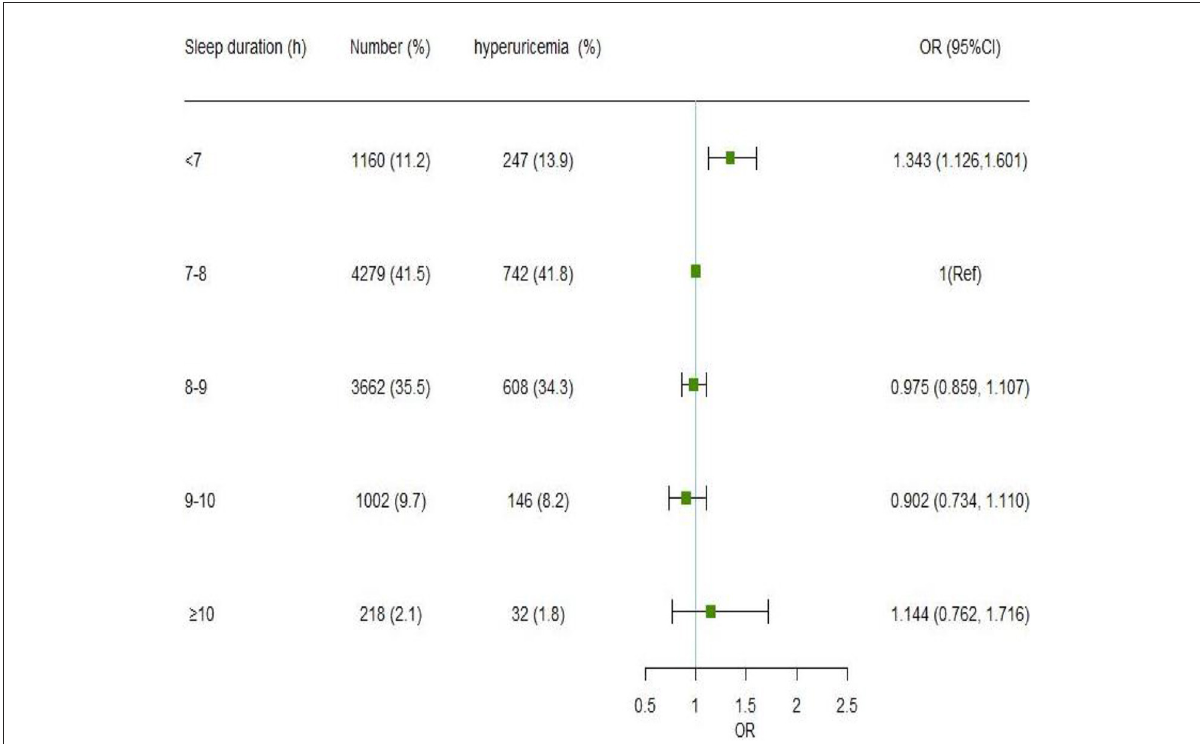
FIGURE1 Association of nocturnal sleep duration with hyperuricemia by the logistic regression model. Model was adjusted for gender, age, marital status, education level, annual household income, work intensity, sedentary time, position levels, participating in physical exercise, smoking, drinking, having mood symptoms, irregular meal habits, midnight snacks, using hypnotics, nap duration, obesity, DM, hypertension, and dyslipidemia. The odds ratio point estimates are shown as small squares, while the 95% CIs are shown as horizontal lines. CI is for confidence interval; Ref stands for